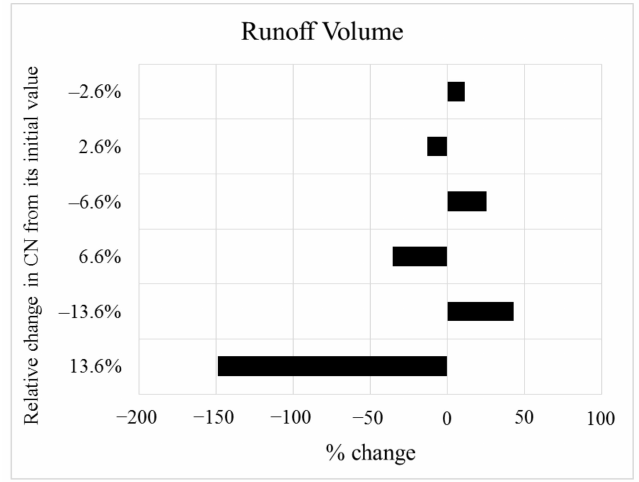
Figure 6. Sensitivity analysis for CN for a contoured row crop with poor hydrological conditions; Fall Creek